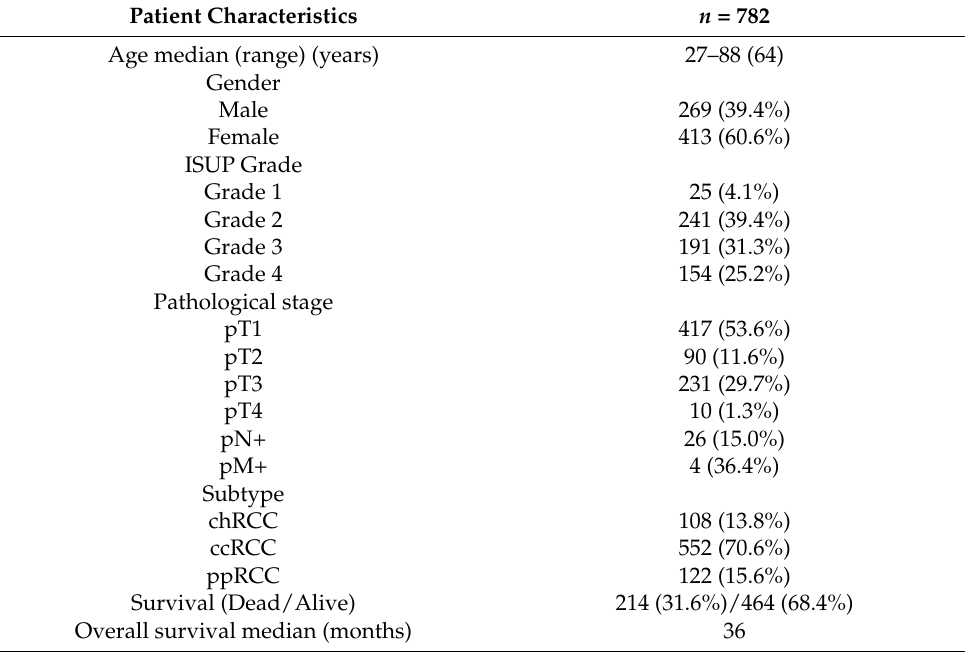
Table 1. Clinical and pathological